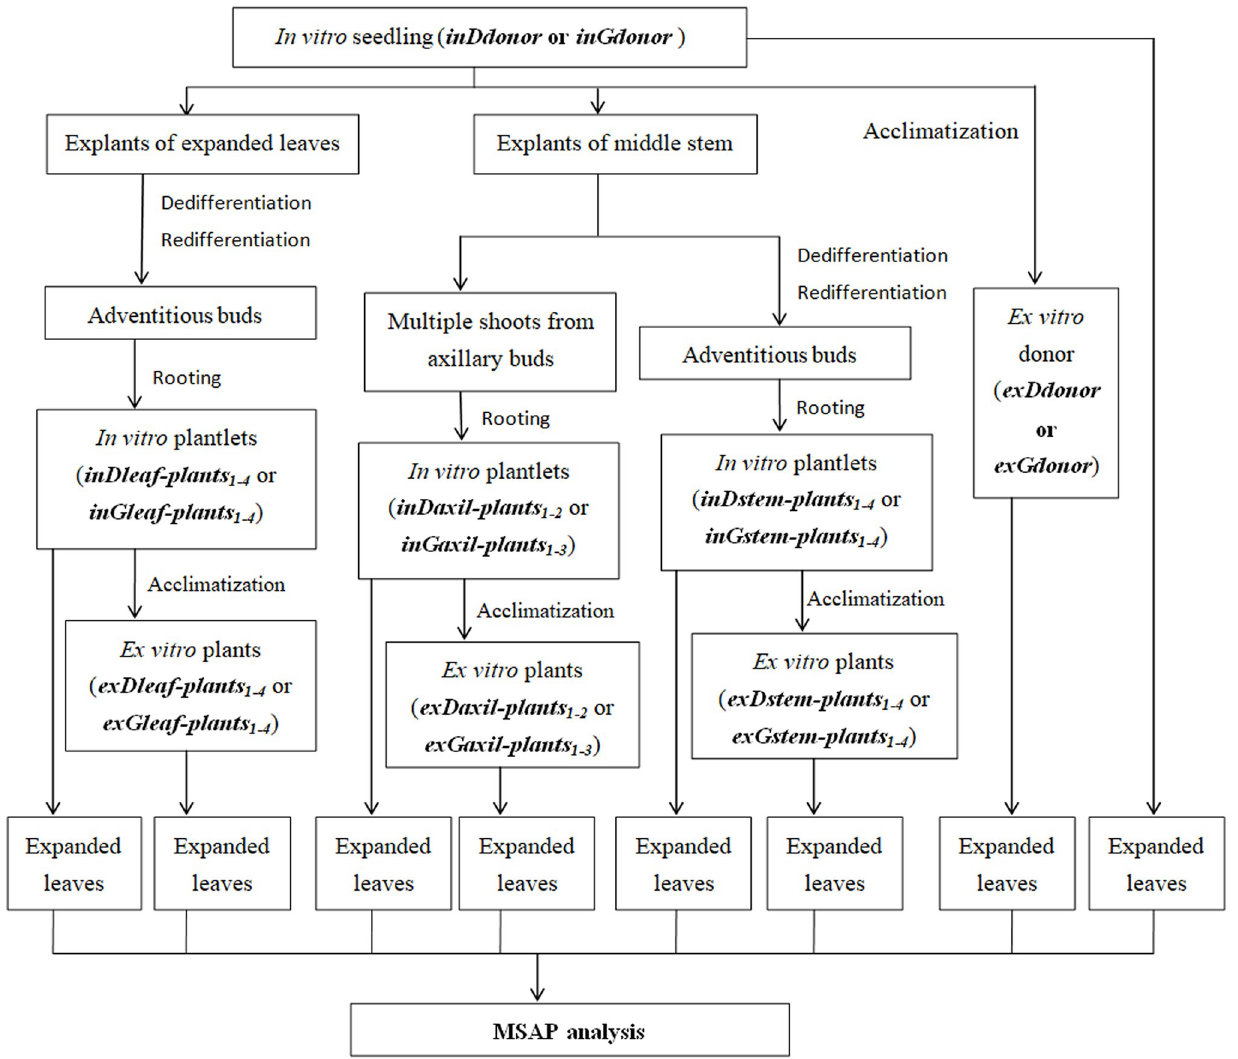
Fig 2. Process used to obtain L . ruthenicum samples of D and G groups used in MSAP analysis. The abbreviations of plants are shown in brackets. Subscripts indicated the number of the plants used in the analysis.